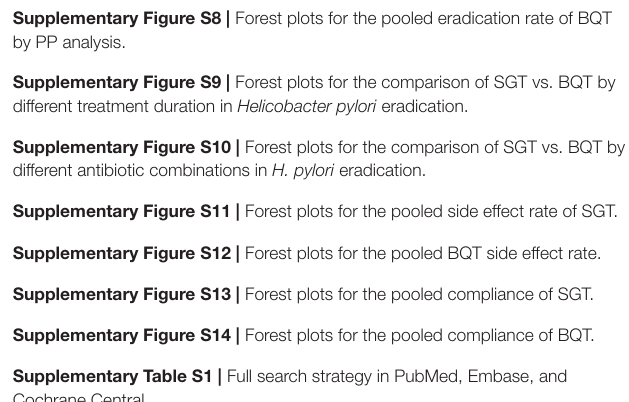
Supplementary Figure S2 | Publication bias evaluated by a funnel plot. Supplementary Figure S3 | Publication bias evaluated by Begg’s test. Supplementary Figure S4 | Publication bias evaluated by Egger’s test. Supplementary Figure S5 | Forest plots for the pooled eradication rate of susceptibility-guided therapy (SGT) by an intention-to-treat (ITT) analysis.